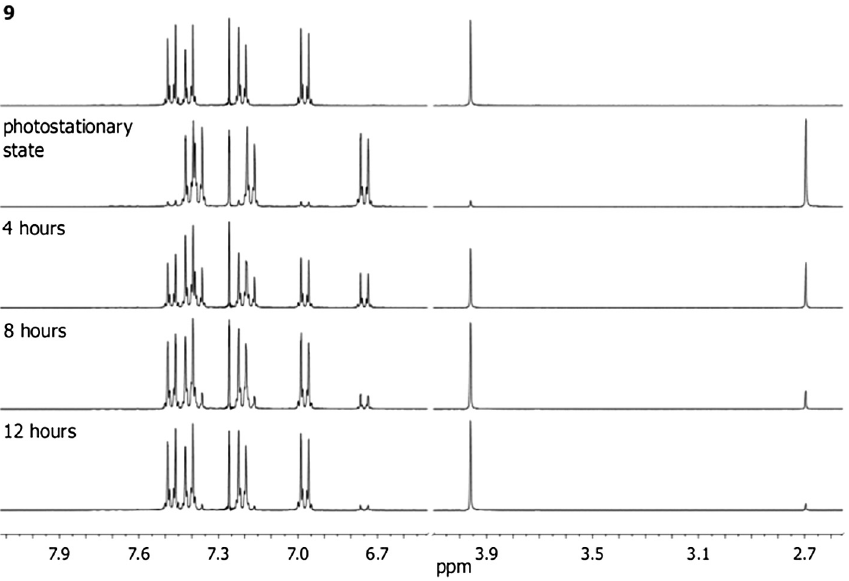
Figure 4. 1 H NMR spectra of quadricyclane to 9 dark at RT in CDCl 3 after illumination at 350 nm. The singlet at 3.9 ppm is from 9 and the singlet at 2.7 ppm is from the corresponding quadricyclane.